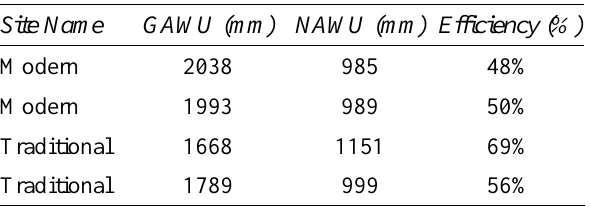
Table 2: Summary of water use 1999/2000 season (dry